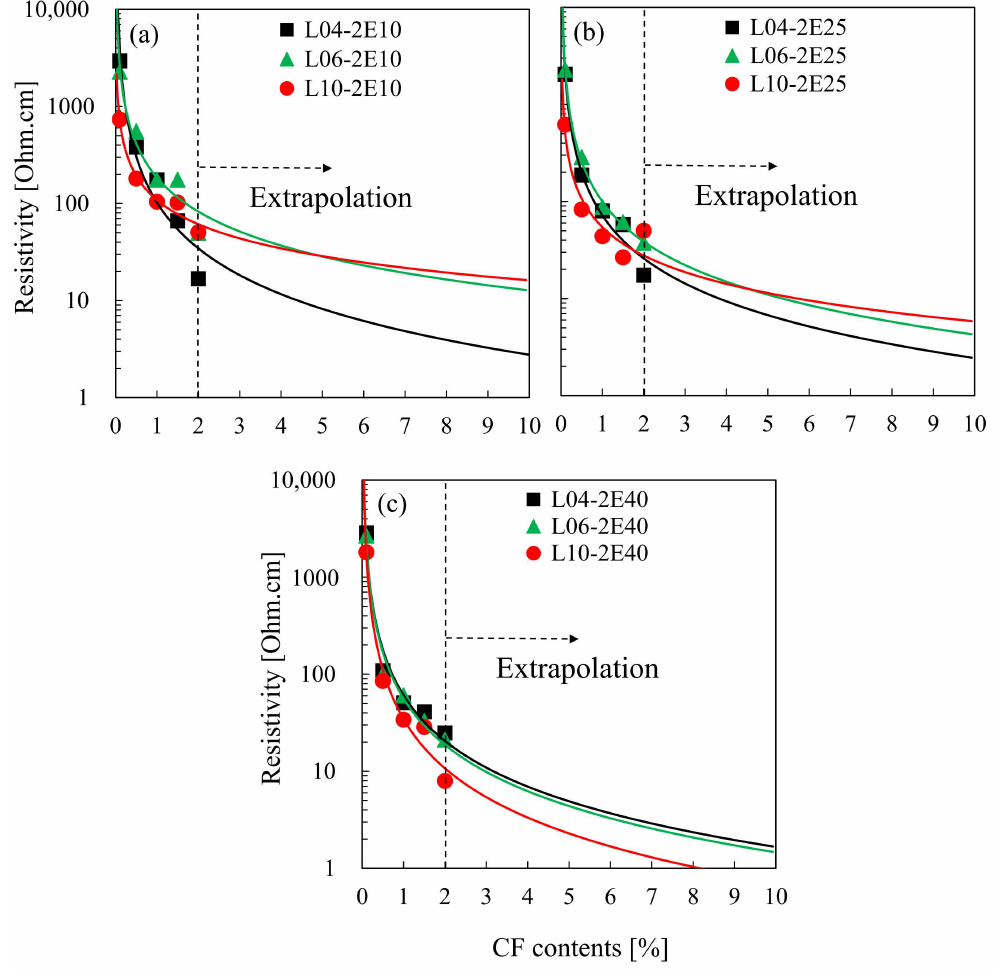
Figure 5. Change in resistivity of cement composites as a function of the carbon fiber (CF) content measured by the two-probe configuration for di ff erent CF lengths and electrode spacings of ( a ) 10 mm (2E10), ( b ) 25 mm (2E25), and ( c ) 40 mm (2E40). L04, L06, and L10 correspond to the CF filament lengths of 4, 6, and 10 mm,